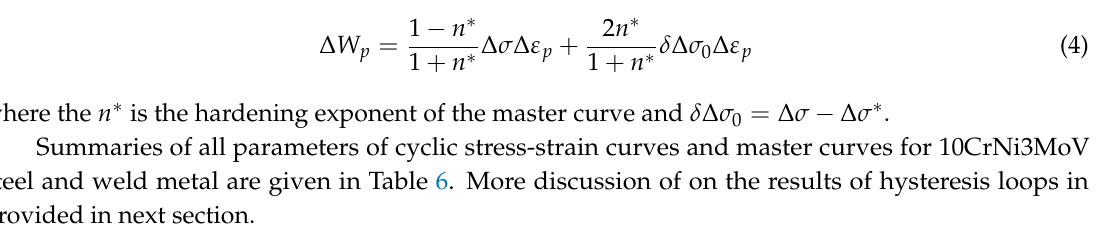
Table 6. Fatigue strength and fatigue ductility parameters of 10CrNi3MoV high strength steel and